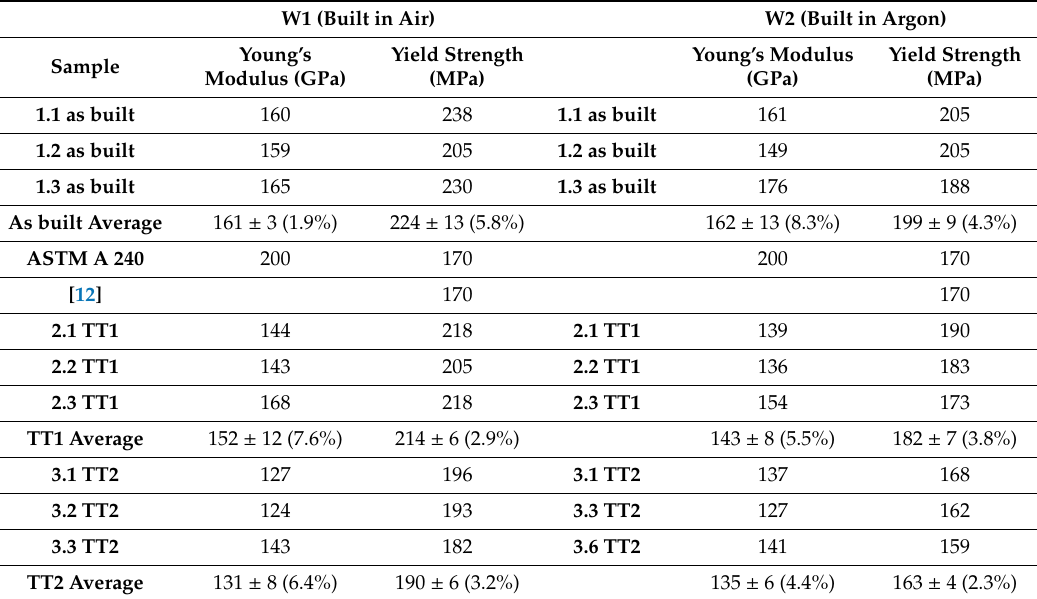
Table 5. Young’s modulus and yield strength results for the specimens studied.